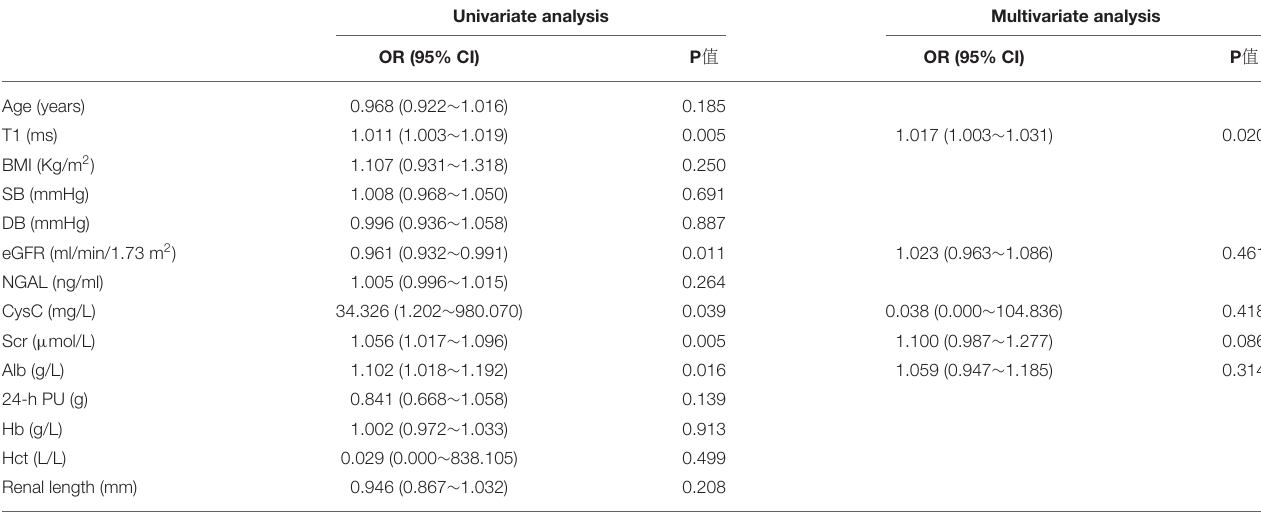
Univariate analysis